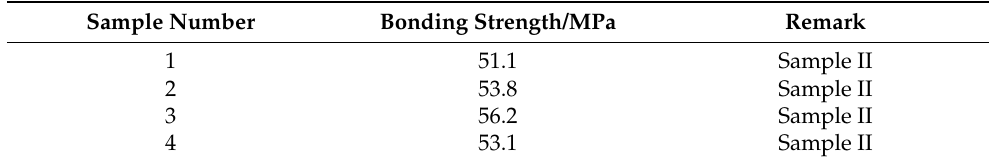
Table 2. Bonding strength of the coating.